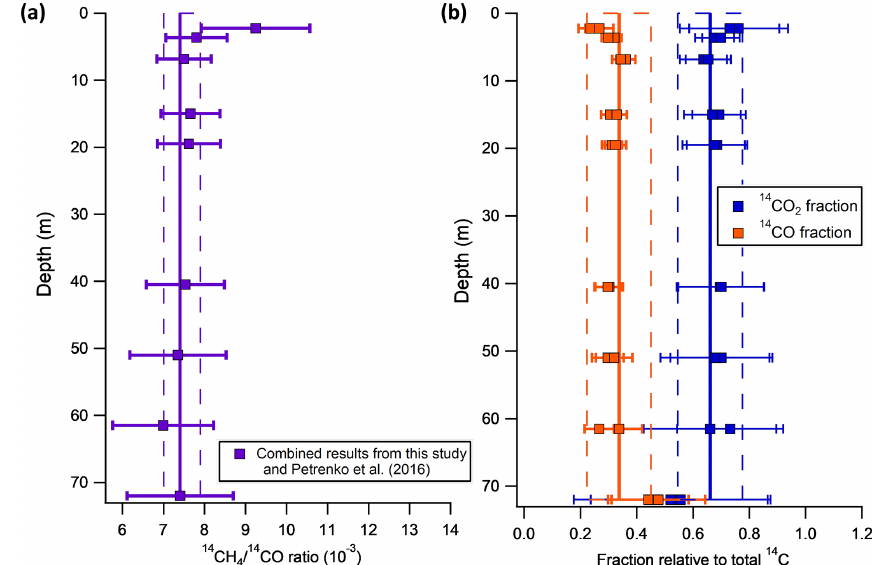
Figure 4. (a) 14 CH 4 / 14 CO. (b) 14 CO/total 14 C and 14 CO 2 /total 14 C ratio. The solid lines represent the mean, and the dashed lines represent 2 standard deviations of the 14 CH 4 / 14 CO ratio, 14 CO 2 , and 14 CO fractions for samples deeper than 6.85m where production by muons dominates. The ratios for rejected samples (Sects. 4.1, S2) are not shown. All error bars shown in this figure are 95%